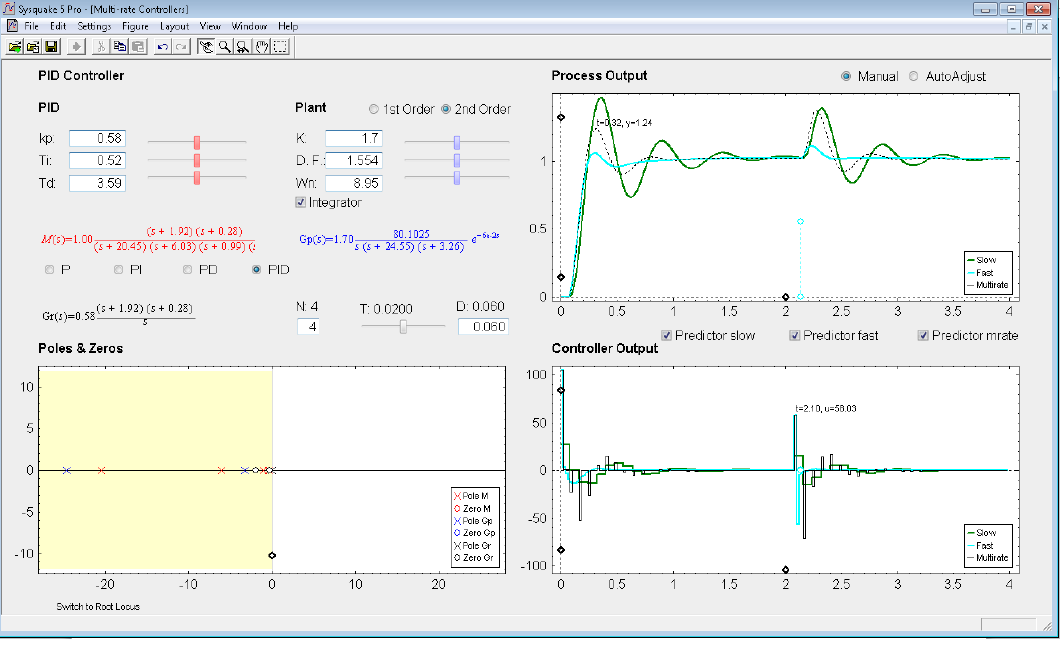
Figure 14. Application user interface for the PID controller with process time delay and